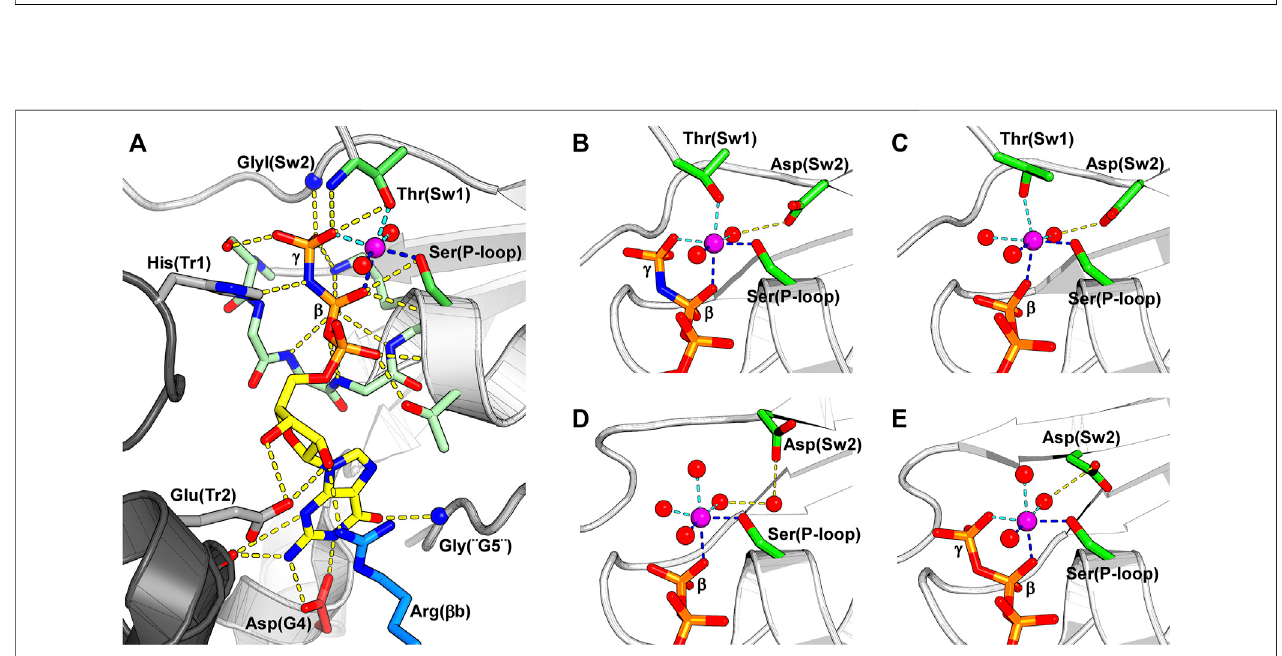
FIGURE5| The nucleotide-bindingpocket and thedifferent modes ofmagnesium coordination. The β -phosphate, Ser(P-loop)and awatermolecule participate in all depicted Mg 2+ coordination schemes, and their coordination to the Mg 2+ is shown by dark blue dotted lines. The magnesium ion is colored in purple. (A) A GTP analogue(GMPPNP) boundtoSEPT12(PDB:6MQ9).Thenucleotideandtheresiduesinteractingwithitarerepresented assticks.Keyresiduesfromtheseptinversions of the fi ve classical nucleotide-binding elements found in small GTPases are labeled: G1 is represented by Ser(P-loop), G2 by Thr(Sw1), G3 by GlyI(Sw2), G4 by Asp(G4) and G5 by Gly( “ G5 ” ).Often septins are said not to possess G2 and G5, but here we describe their remnants explicitly assuch. The conserved arginine from the SUE,Arg( β b),iscoloredinblue.Ontheleftsideofthe fi gure,tworesiduesfromtheothersubunitoftheG-interface(darkgrey)arerepresented;ahistidinefromthe trans - loop 1, His(Tr1), that binds to the β -phosphate, and a glutamate from the trans -loop 2, Glu(Tr2), that forms a hydrogen bond to the ribose ring. (B) Magnesium coordination in acatalytically active septinboundtothe non-hydrolysableGTPanalogue,GMPPNP (PDB:6MQ9). (C) A tightly boundMg 2+ in acatalytically active septin boundtoGDP.Thr(Sw1)remainsasaligandinthiscase,andAsp(Sw2)continuestocoordinatethemetalviaawatermolecule(PDB:6MQK). (D) Ina weakly boundMg 2+ ion, also in the presence of GDP, Thr(Sw1) has now been replaced by a water molecule, and the participation of Asp(Sw2) is mediated by two waters rather than one (PDB:6N12). (E) Magnesiumcoordinationinanon-catalyticseptinboundtoGTP.TheMg 2+ coordinationsphereisformedbythe β -and γ -phosphates,Ser(P-loop)and three water molecules, one of which is held by the side chain of Asp(Sw2) (PDB:6UPQ).